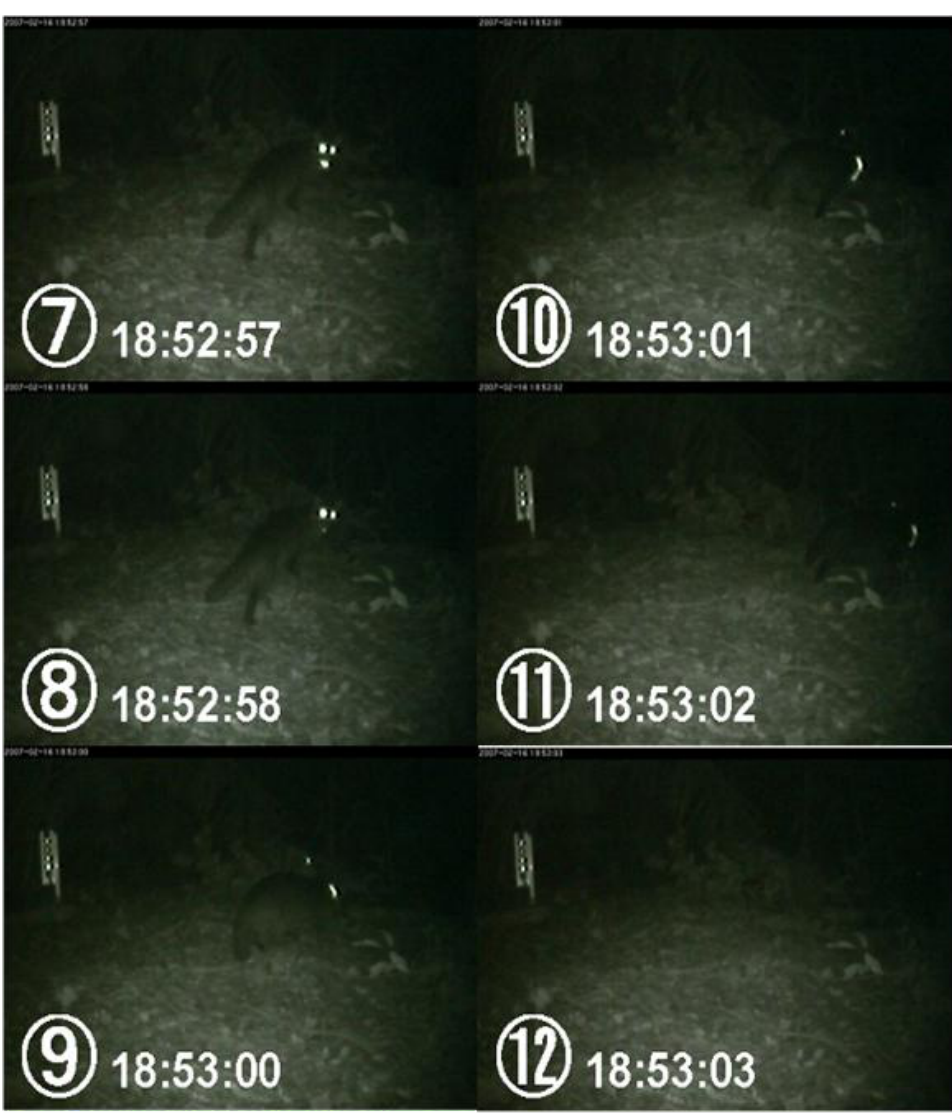
Figure 18. Infrared pictures taken by our